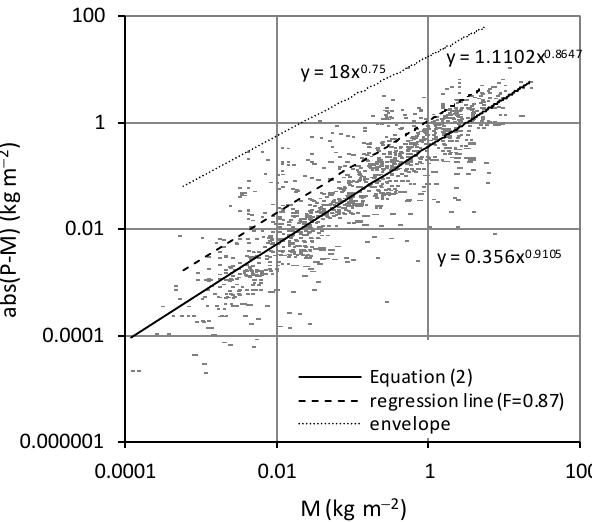
Figure 10. Plot of the absolute difference in measurement of soil loss between replicated plots, | P − M |, vs. the measured value, M , and of Equation (2), the regression line associated with a frequency F = 0.87 and the data enveloping line (modified from [42]).